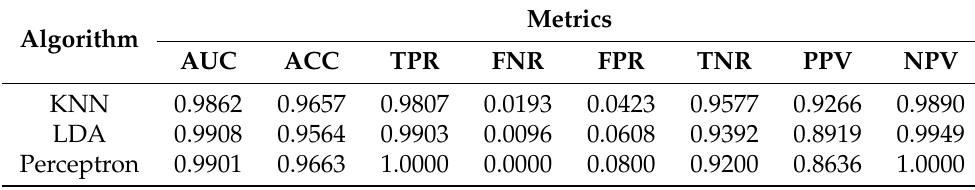
Table 4. The mean value for each metric for each algorithm—Breast Cancer Wisconsin dataset.